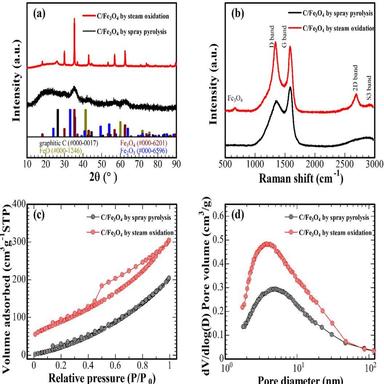
XRD patterns (a), Raman spectrums (b), N2 adsorption/desorption isotherms (c) and pore-size distribution (d) of the C/Fe3O4 microspheres prepared by spray pyrolysis and by steam oxidation.